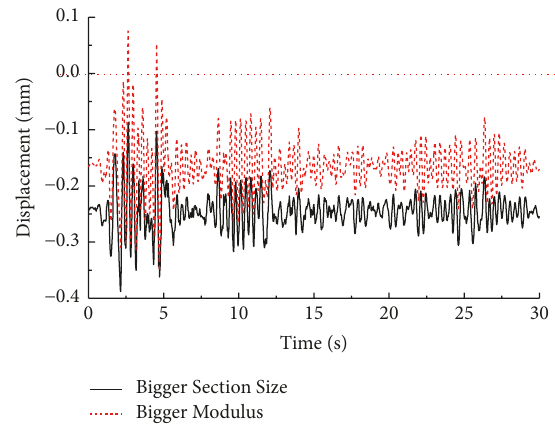
Figure 30: Vertical displacement time history curves at node 1 on the structure base mat under two cases: Bigger Section Size case and Bigger Modulus case.